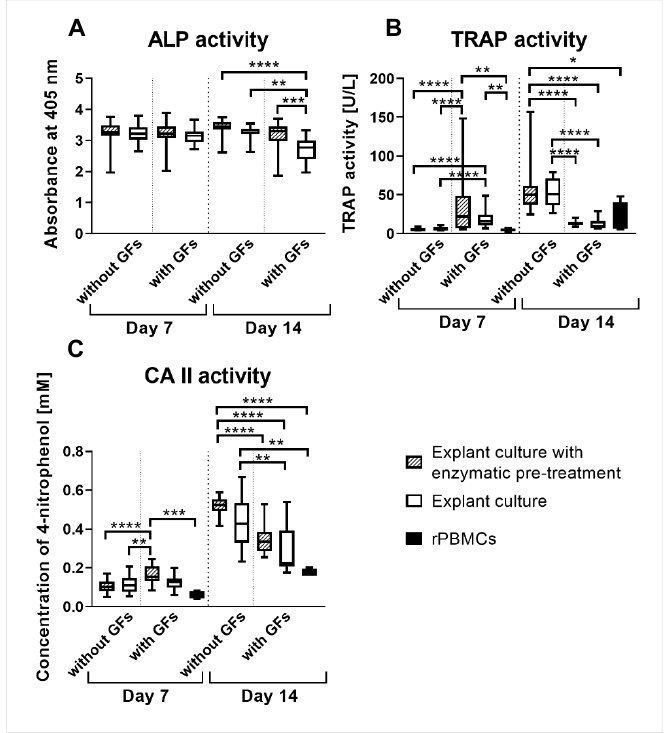
Figure 5. ALP ( A ), TRAP ( B ), and CA II ( C ) activity in co-cultures of rPBMCs and rOBs isolated either by explant culture with enzymatic pre-treatment or by explant culture on days 7 and 14. Cells were co-cultured with or without exogenous GFs (M-CSF, RANKL). rPBMCs monoculture served as a control of osteoclastogenesis in TRAP and CA II activity measurement and was cultured only with exogenous GFs. The statistical difference is marked as a link above the groups. * p < 0.05, ** p < 0.01, *** p < 0.001, **** p < 0.0001.